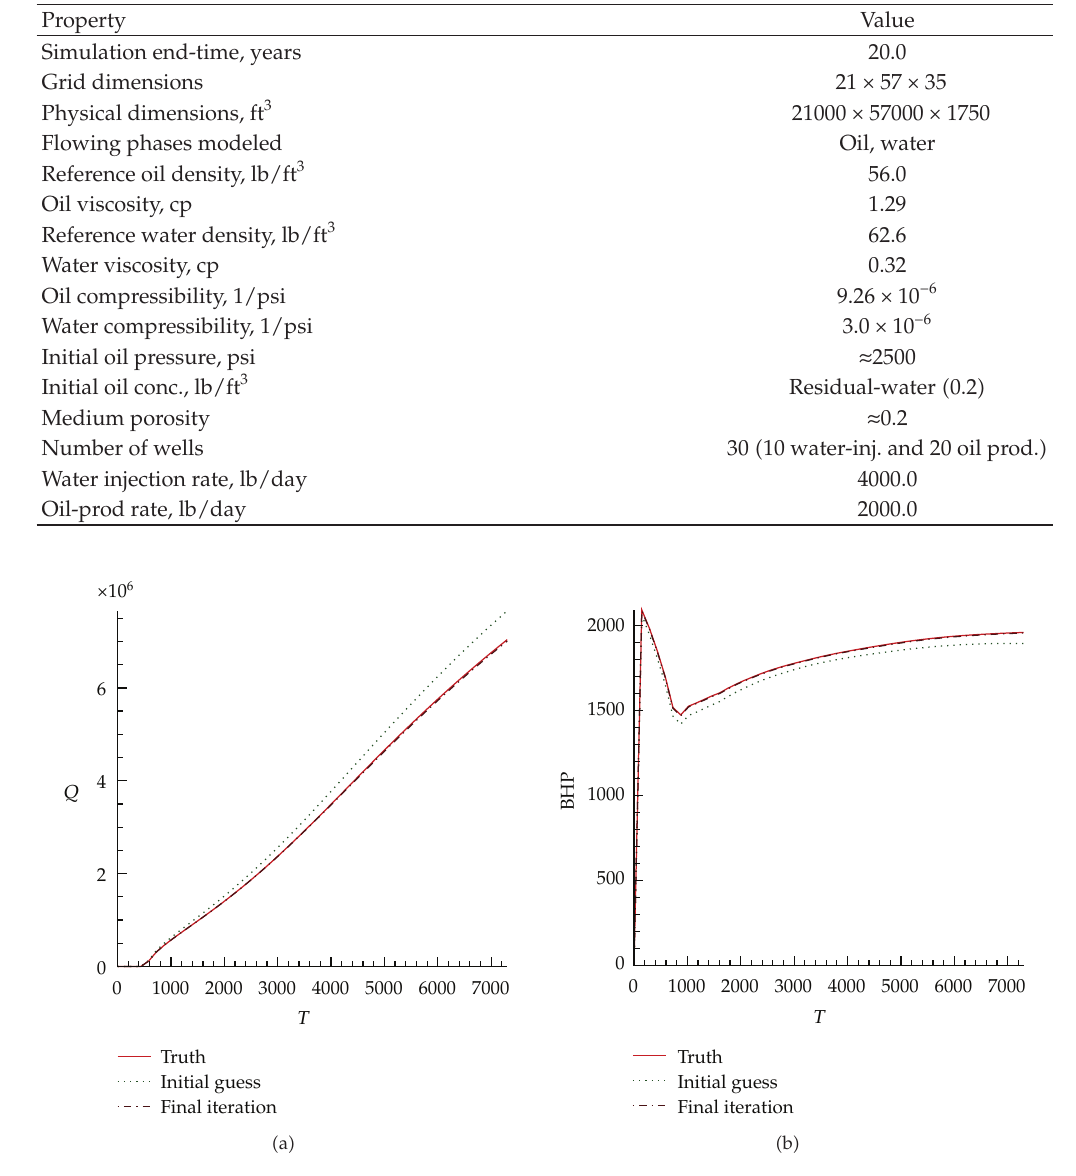
Table 2: Parameter estimation: data for example 2 (cid:6) Brugge field test (cid:7) .